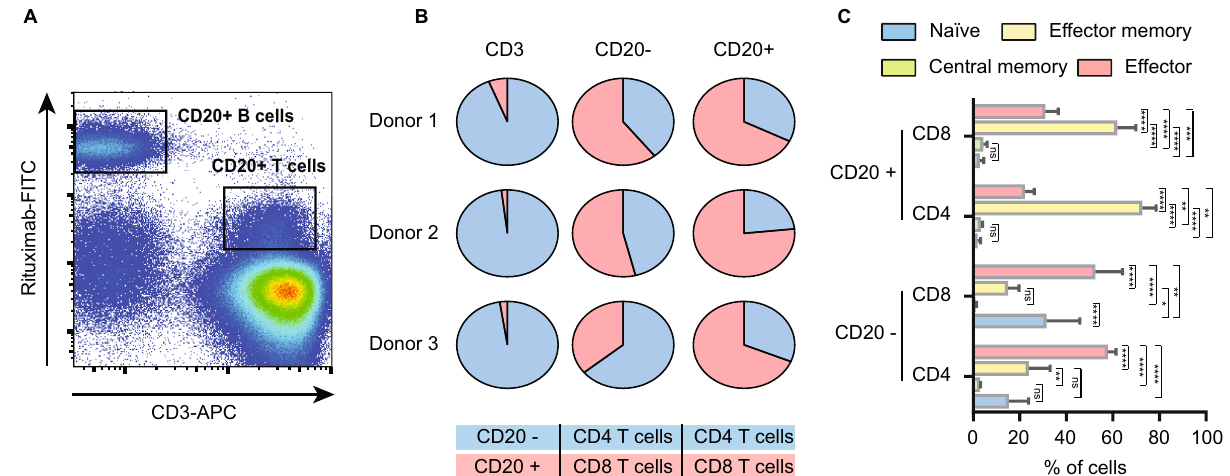
Figure 1. Flow cytometry analysis reveal CD20 + T cells predominantly display an effector memory phenotype. ( A ) Flow cytometry plot displaying FITC conjugated Rituximab binding on B cells and on T cells. One representative healthy donor is depicted. ( B ) Pie charts displaying CD20 + popualtion within a CD3 + population, distribution of CD4 + and CD8 + subsets within the CD20- popualtion and the distribution of CD4 + and CD8 + subsets within the CD20 + population (n = 3). ( C ) Bargraph displaying T cell differentiation status within the CD20-/CD20 + populations and within the CD4 + / CD8 + subsets (n = 3). A 2way ANOVA was performed to deterime